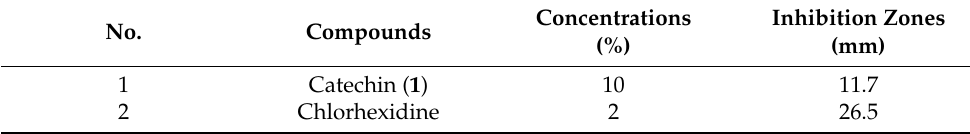
Table 2. The inhibition zones of compound 1 against E. faecalis ATCC 29212.